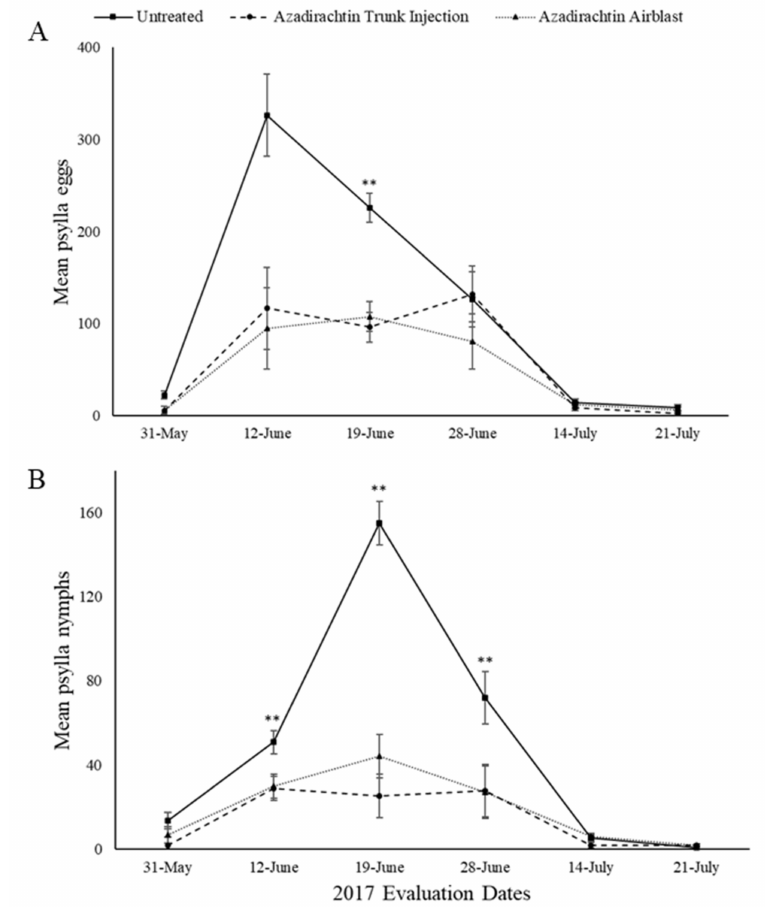
Figure 1. Mean number of pear psylla eggs ( A ) and nymphs ( B ) per 50 leaves in 2017 evaluations for the untreated and azadirachtin treatments. Values with ** above them represent a significant di ff erence ( p ≤ 0.05) between the untreated and both injection and airblast